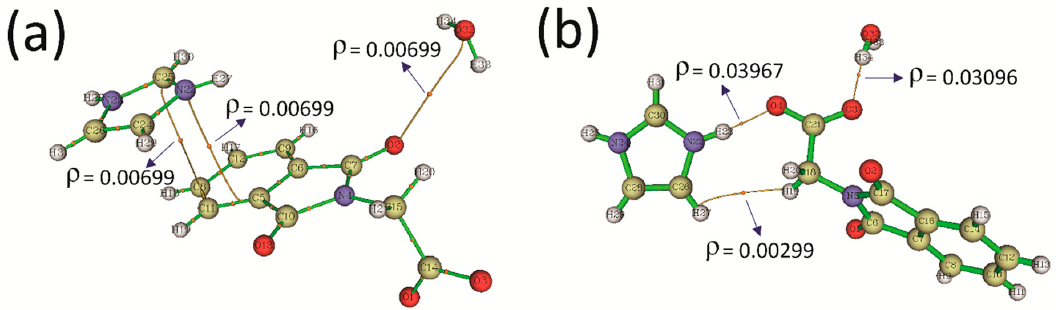
Figure 7. QTAIM-analysis-based molecular graph of two di ff erent configurations of IM + –NPG − –HYD : ( a ) A and ( b ) B , both showing the BP and electron density ( ρ ) computed at bond critical points (BCPs). Orange circles indicate the BCPs.